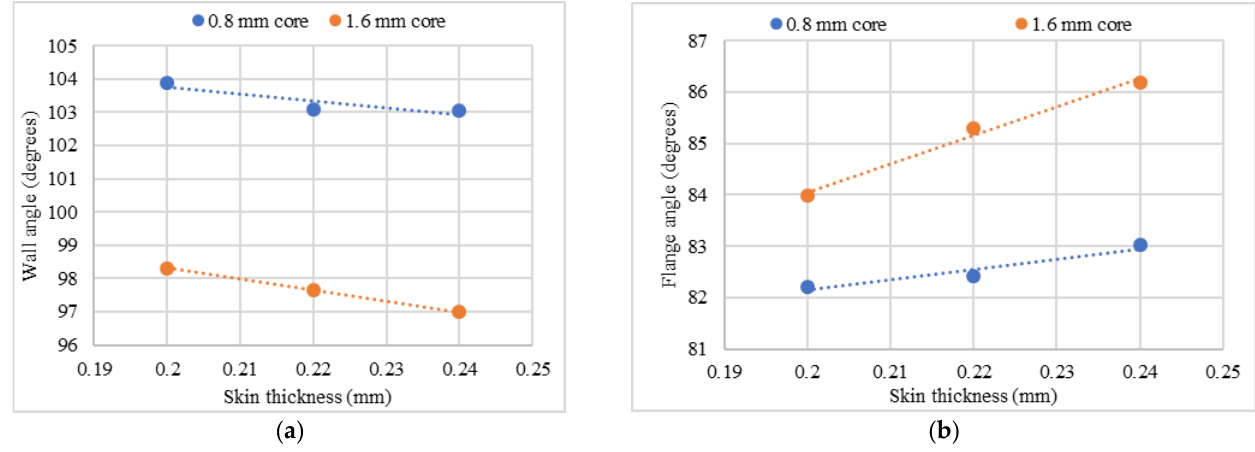
Figure 9. ( a ) Wall angle and ( b ) flange angle with varying skin thickness for laminates with 0.8 mm and 1.6 mm core thicknesses.